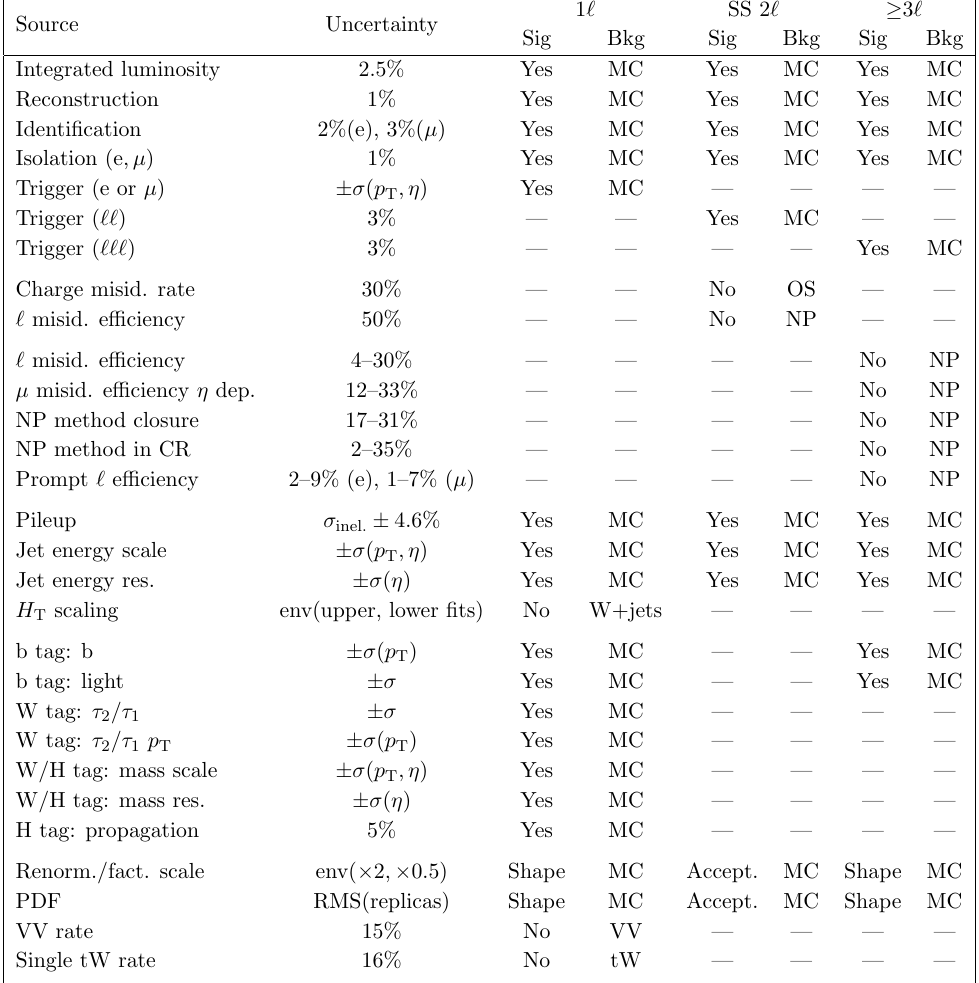
Table 3 . Summary of values for normalization uncertainties and dependencies for shape uncer- tainties. The symbol (cid:27) denotes one standard deviation of the uncertainty and \env" denotes an envelope of values. Background from opposite-sign dilepton events is denoted \OS", background from nonprompt leptons is denoted \NP", while other backgrounds modeled from simulation are de- noted \MC". For signals, theoretical uncertainties are labeled as \Shape" for shape-based searches, and \Accept." for counting experiments. Additionally, \CR" denotes control region and \RMS" denotes root mean